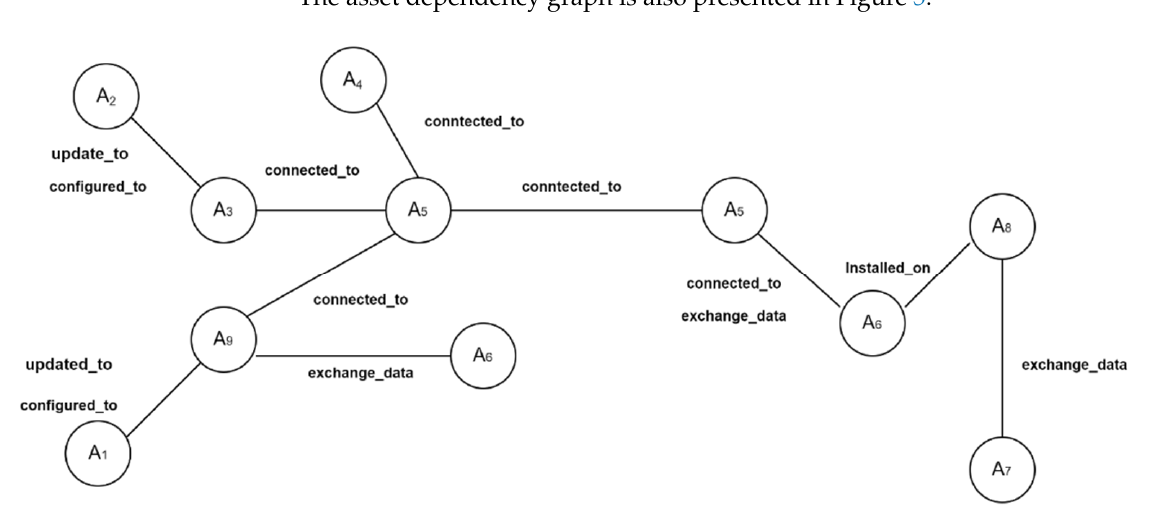
Figure 5. Asset-dependency graph.